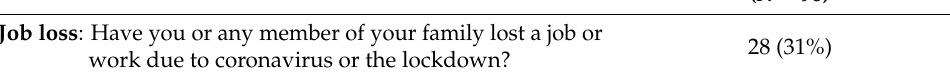
Table 4. Reported changes and challenges associated with economic and food security as a result of COVID-19 or lockdowns. Interview Question